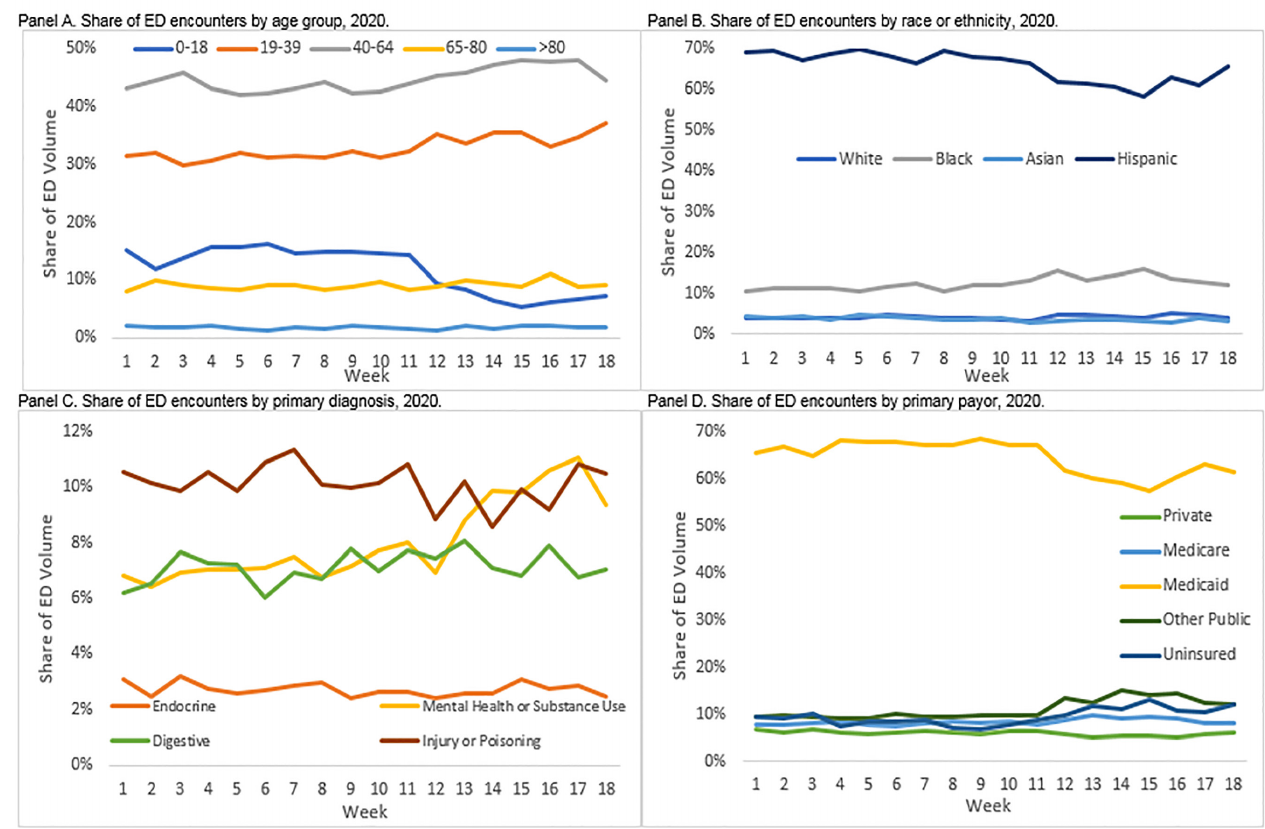
Figure 3. Distribution of emergency department (ED) volume by week and selected characteristics,